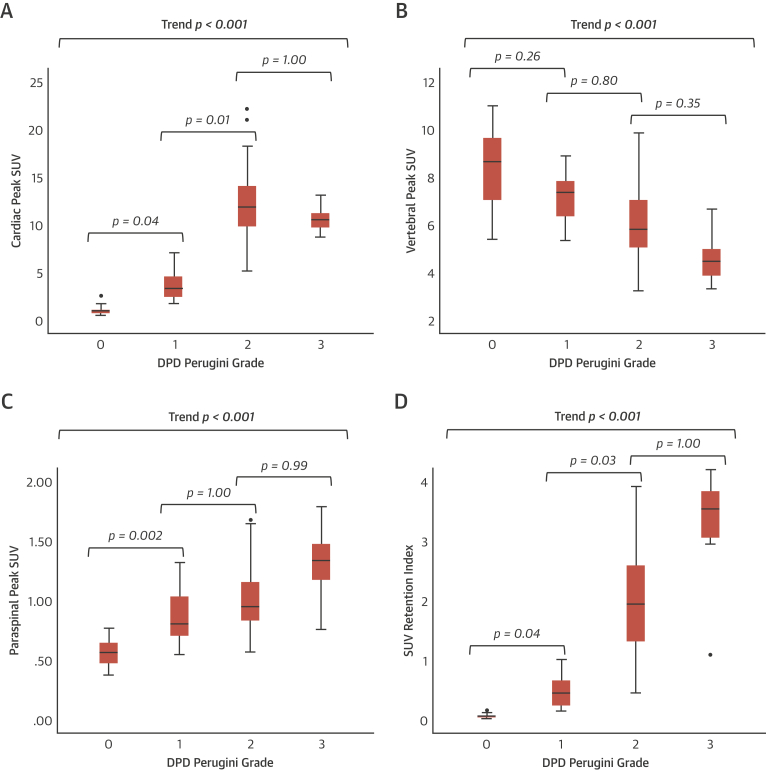
Trends in SPECT/CT Quantification by DPD Perugini GradeBox and whisker plots illustrating the trend seen with increasing 99mTc-3,3-diphosphono-1,2-propanodicarboxylic acid (DPD) Perugini grade in SUVpeak in the heart (A), vertebra (B), paraspinal muscle (C), and the composite SUV retention index (D). Whisker lengths extend to 1.5 times the box height, or if no case has a value in that range, to the minimum and maximum. Dots represent outliers. Abbreviations as in Figure 1.